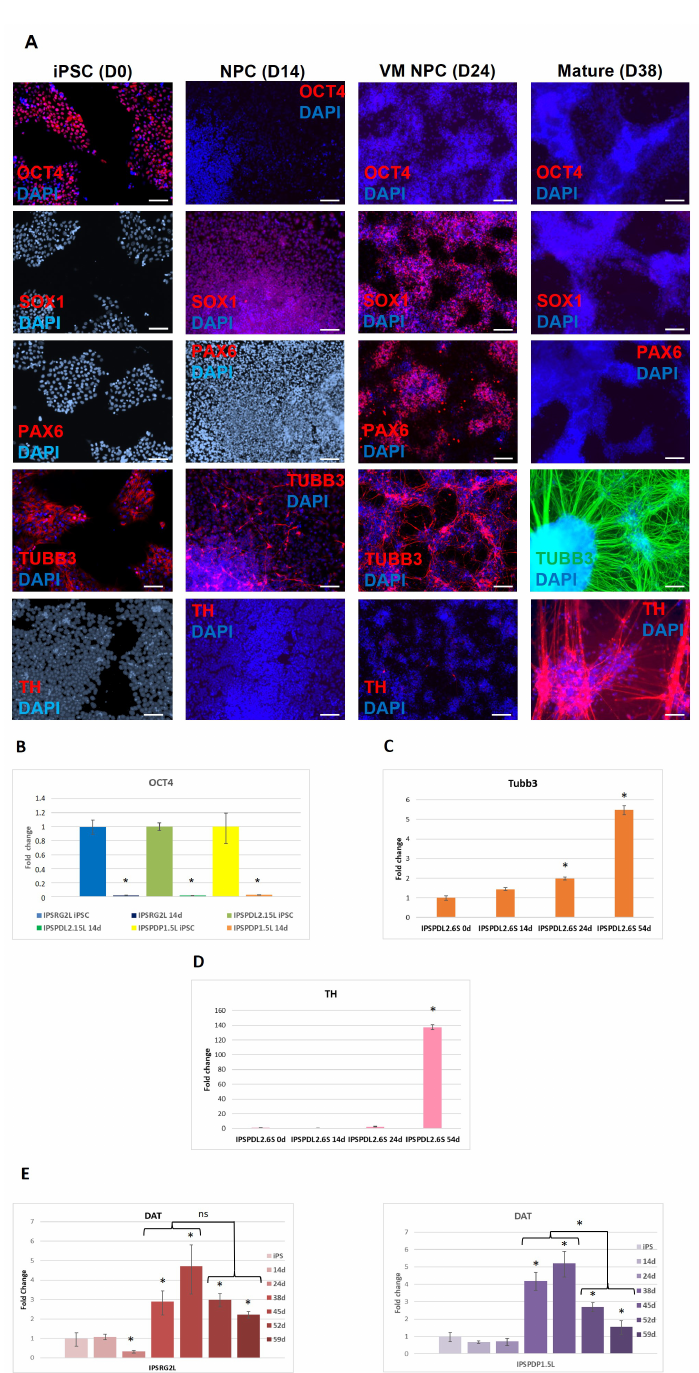
Figure 2. Analysis of the expression of the pluripotent state marker and neuronal differentiation markers at different stages of differentiation. ( A )—immunofluorescence analysis of sequential steps of differentiation for the expression of the pluripotent state marker OCT4, markers of neural progenitors SOX1, PAX6, neuronal marker β -III-tubulin and DAns marker tyrosine hydroxylase (TH) on the example of iPSC line IPSRG2L from a healthy donor. NPC—common neural progenitors (differentiation day 14), VMNPC—ventral midbrain neuronal progenitors (differentiation day